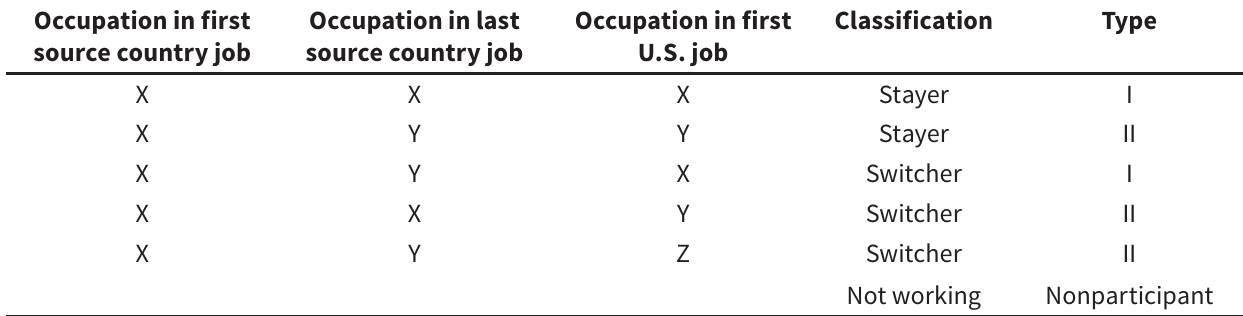
NIS interview questions and classification as stayer, switcher, and nonparticipant Occupation in first source country